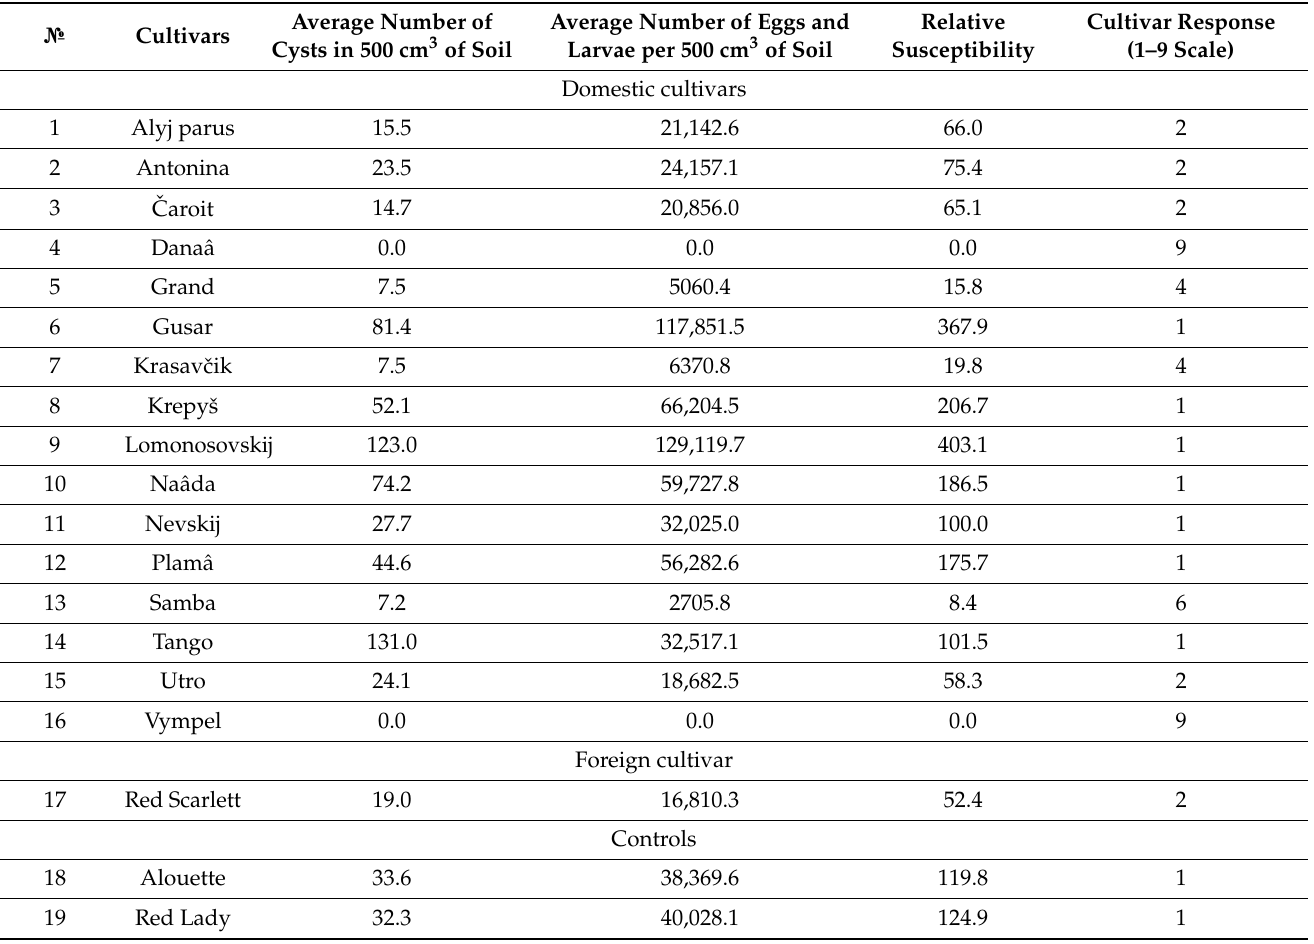
Table 5. Resistance of potato cultivars to G. pallida pathotype